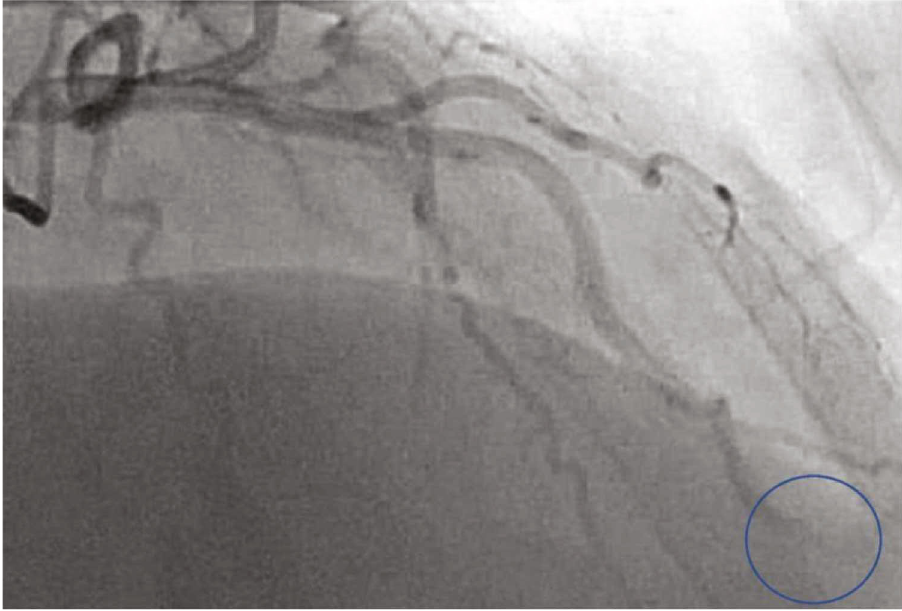
Figure 3: Left heart catheterization via the right radial approach. Selective angiograph of the left coronary artery in the right anterior oblique cranial projection revealing a distally occluded left anterior descending artery with thrombus (blue